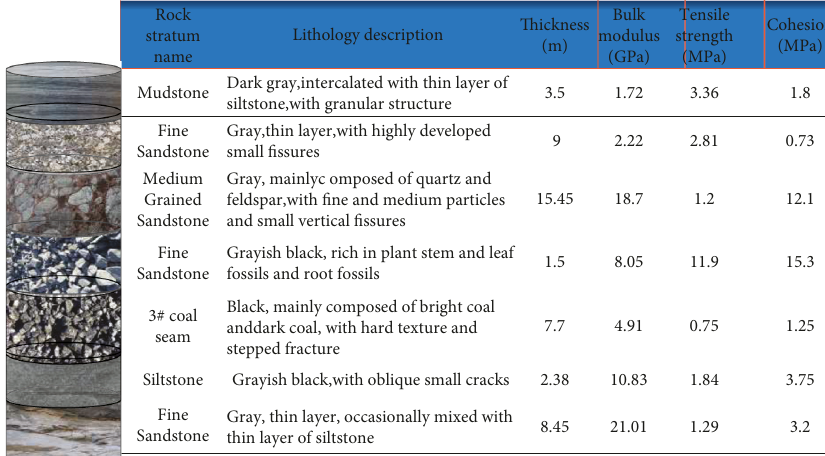
Figure 4: Rock thickness and physical and mechanical property description